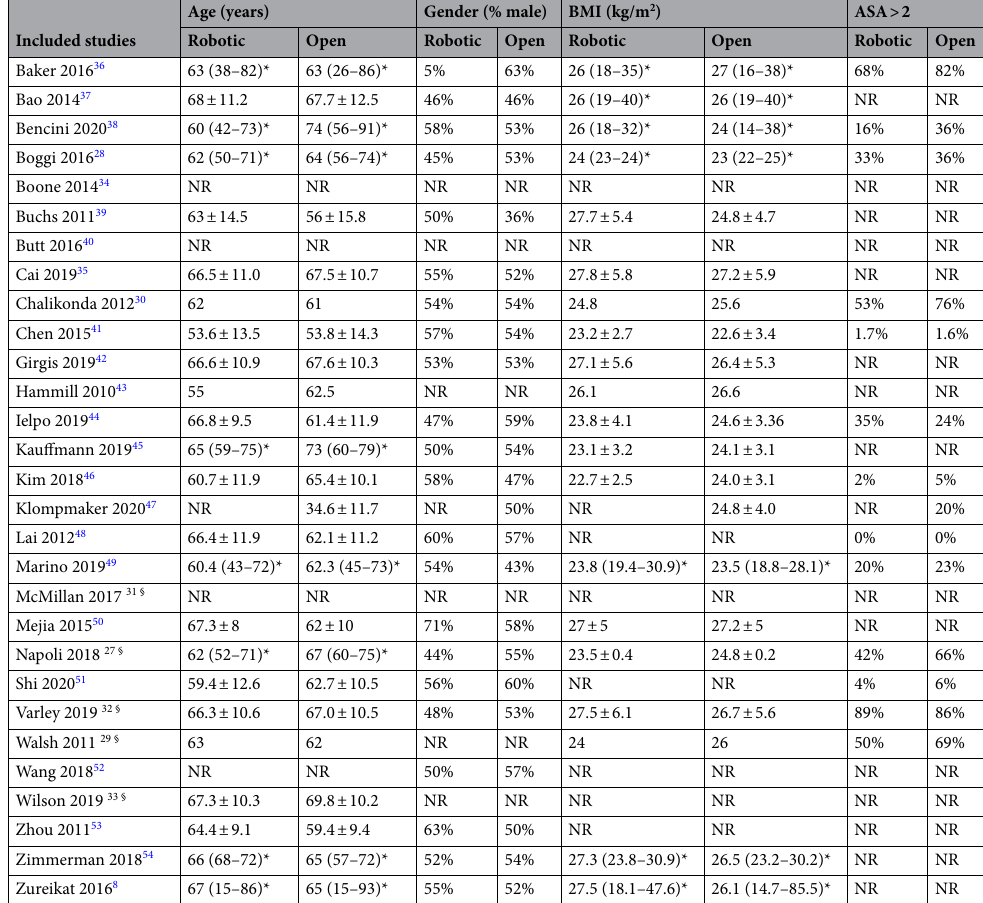
Table 2. Comparison of patients’ baseline characteristics in robotic vs. open pancreaticoduodenectomy. BMI body mass index; ASA American Society of Anesthesiologists; NR not reported. *Expressed in median and interquartile range. § Studies that were excluded from the quantitative